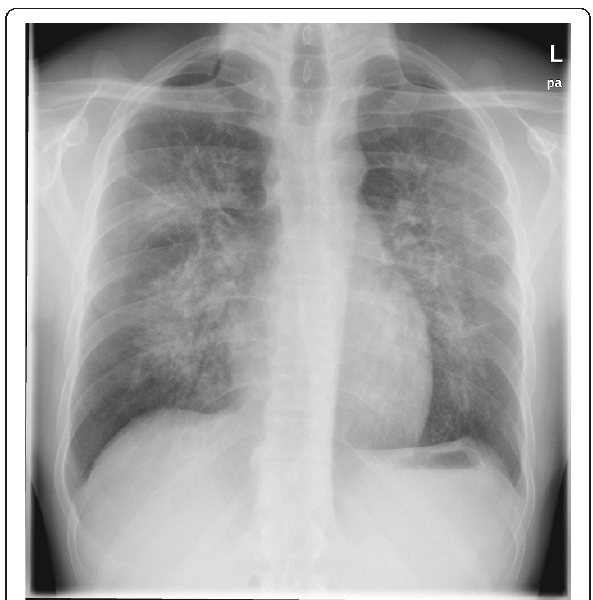
Figure 1 Chest x-ray showing centrally pronounced bilateral pulmonary infiltrates with ground-glass opacities